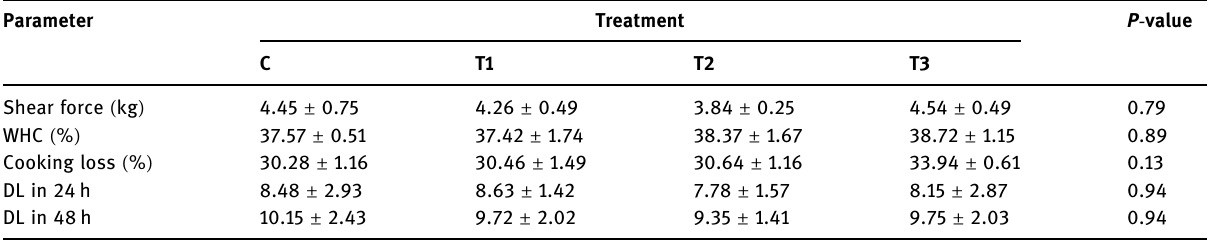
Table 11: Shear force, cooking loss, WHC, and DL of LD muscle of DFM - o ff ered growing Najdi lambs weaned at di ff erent ages ( mean value ± SE )